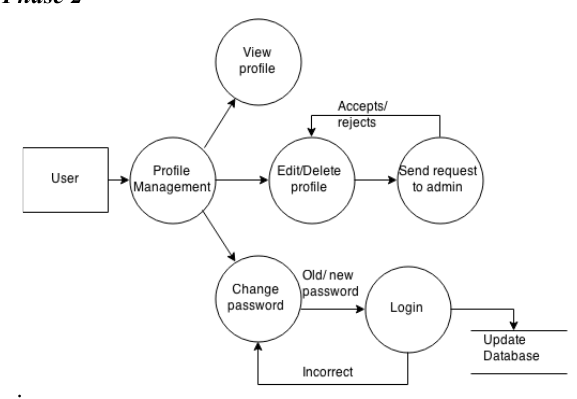
Figure 10. Level 2 DFD for the user logged into the system